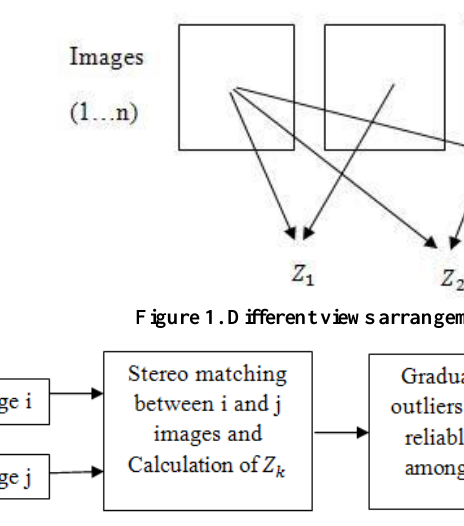
Figure 2. Block diagram of virtual view synthesis by the proposed